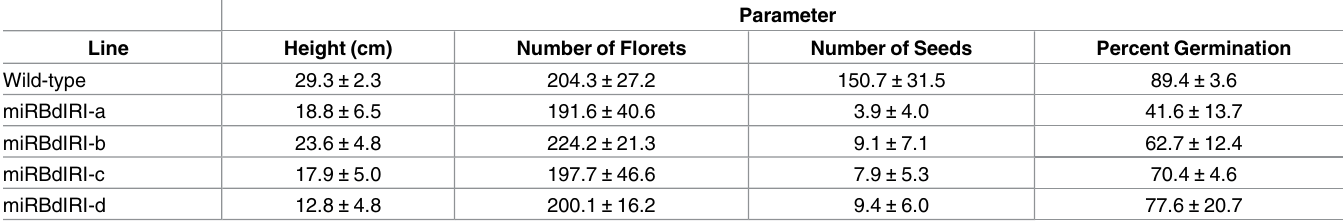
Table 2. Developmental characteristics of wild-type B . distachyon and miRBdIRI knockdown